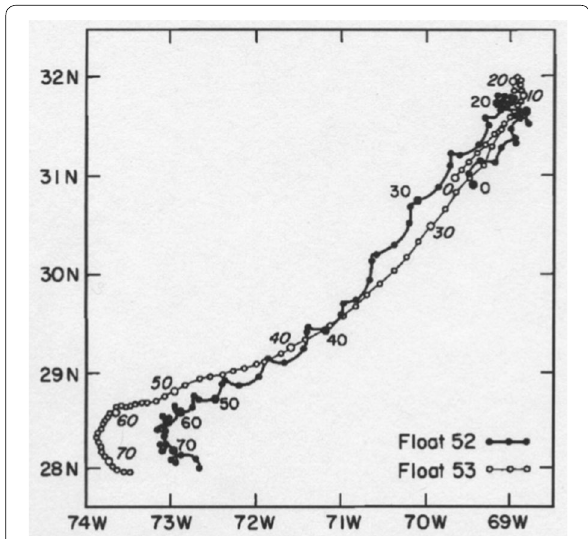
Fig. 15 Float track inside an atlantic SCV. Tracks of two acoustically tracked floats at 700 m depth near Bermuda (Riser et al. 1986). They were deployed at day 0 about 20 km apart and stayed close together over a period of more than 70 days while being advected by mesoscale currents. One of these was inside a SCV, the other not. Intersecting hydrographic profiles showed a large, trapped water mass anomaly in T–S and O 2 , indicating a subpolar origin for the